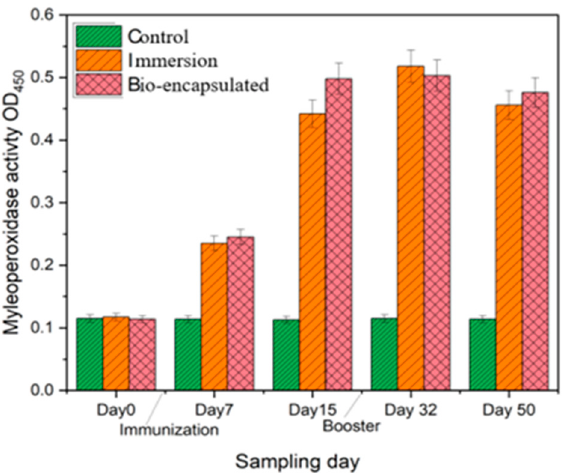
Figure 8. Intestinal tissue myeloperoxidase activity (MPO) of the juvenile Cyprinus carpio L. in three groups, control, bio-encapsulated and immersion at day 0, 7, 15, 32 and 50.